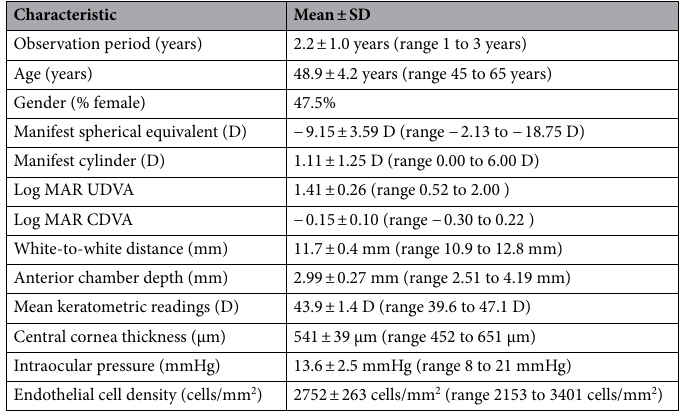
Table 1. Preoperative demographics of the study population. Log MAR logarithm of the minimal angle of resolution, UDVA uncorrected distance visual acuity, CDVA corrected distance visual acuity.